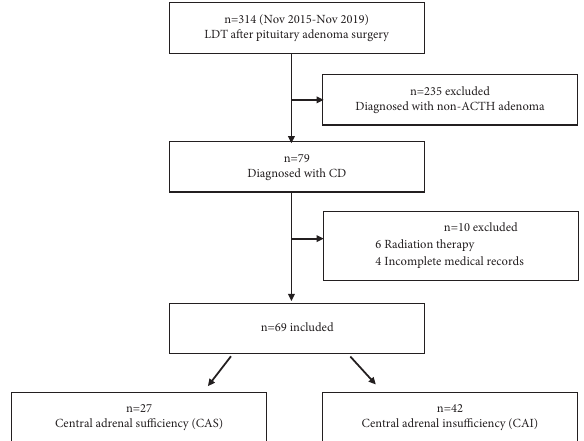
Figure 1: Flowchart of patient enrollment. LDT, low-dose ACTH stimulation test; ACTH, adrenocorticotropic hormone; CD, Cushing’s